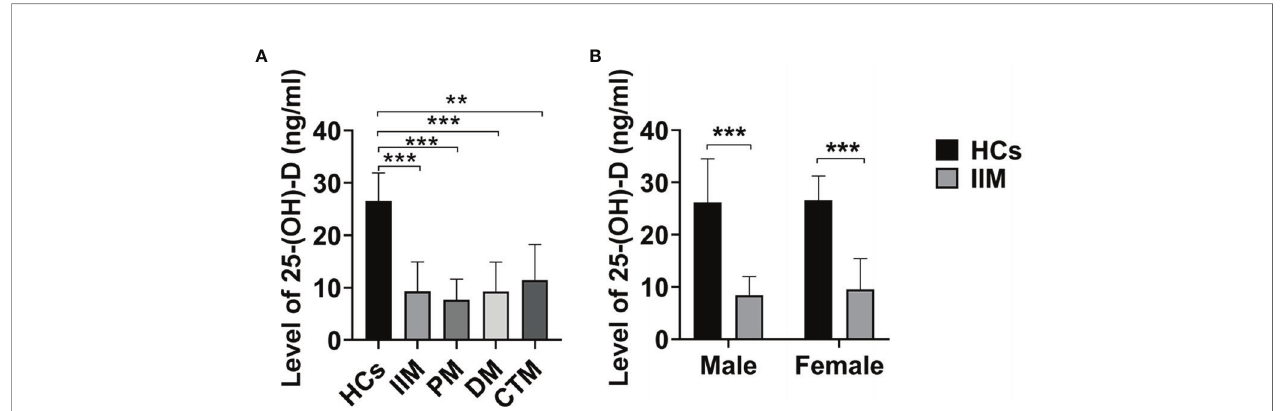
FIGURE 1 | The levels of 25-(OH)-D (ng/ml) in IIM patients and HCs. (A) The levels of 25-(OH)-D in IIM and its subgroups were signi fi cantly lower than those of HCs. (B) The levels of 25-(OH)-D in IIM were signi fi cantly lower than those of HCs in male and female. HCs, Healthy controls; IIM, idiopathic in fl ammatory myopathy; PM, polymyositis; DM, dermatomyositis; CTM, connective tissue myositis. **p < 0.01, ***p < 0.001 by independent samples t-test.